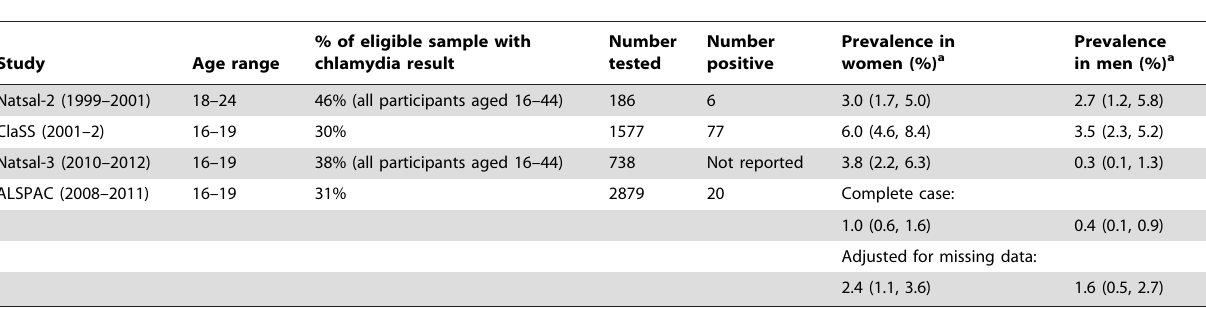
Table 6. Recent UK population based studies of prevalence of chlamydia in the general population.